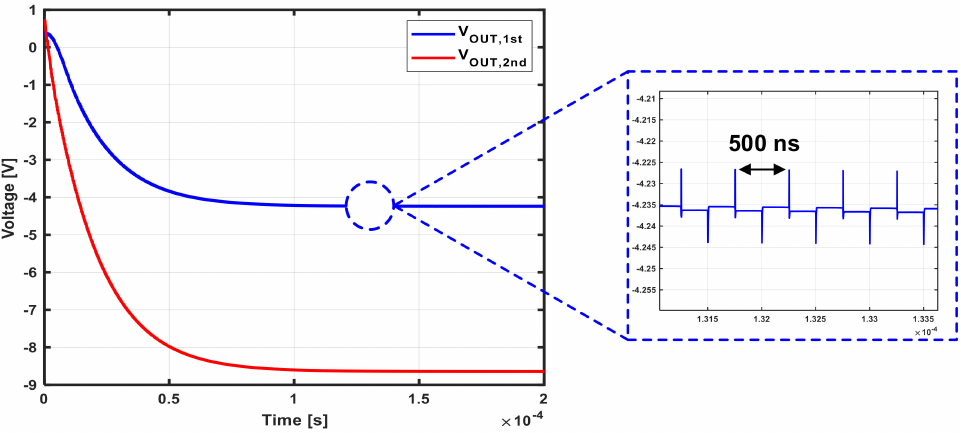
Figure 8. Simulated negative voltage generator outputs.